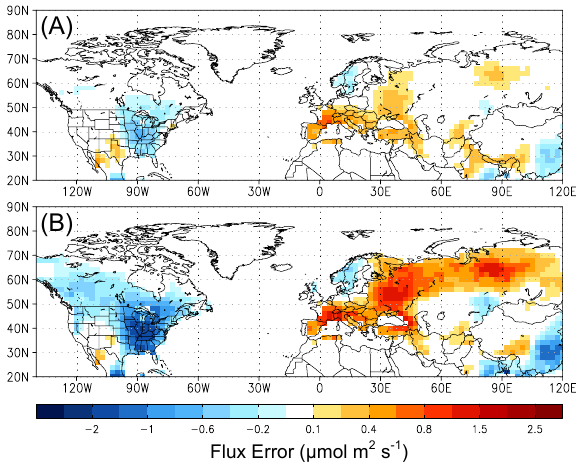
Fig. 8. Flux errors in Experiment 5, averaged over (A) 1yr and (B)